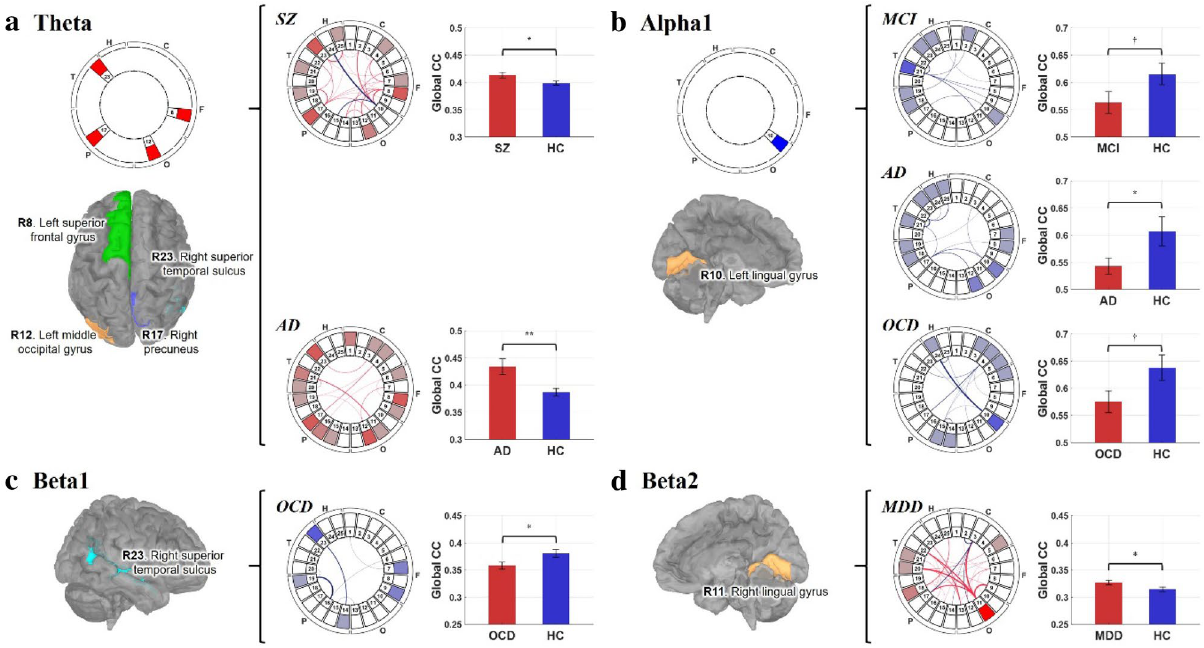
Figure 4. DMN CC index analysis results. Only the results showing significantly different global CC indices are presented. For each frequency band, key ROIs are highlighted on the brain image left side; additionally, if more than one is included, common key ROIs are also illustrated as a form of DMN pattern. DMN patterns and the comparisons of global CC indices are presented right side. In the bar charts, red bars indicate disorder groups, and blue bars show HC groups. The error-bars indicate standard error. ( a ) In the theta band DMN, SZ and AD commonly showed strong hyper-clustering in four regions: left superior frontal gyrus (R8), left middle occipital gyrus (R12), right precuneus (R17), and right superior temporal sulcus (R23). ( b ) In the alpha1 band DMN, MCI, OCD, and AD commonly showed hypo-clustering in the left lingual gyrus (R10). ( c ) In the beta1 band DMN, OCD showed strong hypo-clustering in the right superior temporal sulcus (R23). ( d ) In the beta2 band DMN, MDD showed strong hyper-clustering in the right lingual gyrus (R11). † p < 0.07, *p < 0.05, **p < 0.01 ( SZ schizophrenia, AD Alzheimer’s disease, OCD obsessive compulsive disorder, MCI mild cognitive impairment, MDD major depressive disorder, HC healthy